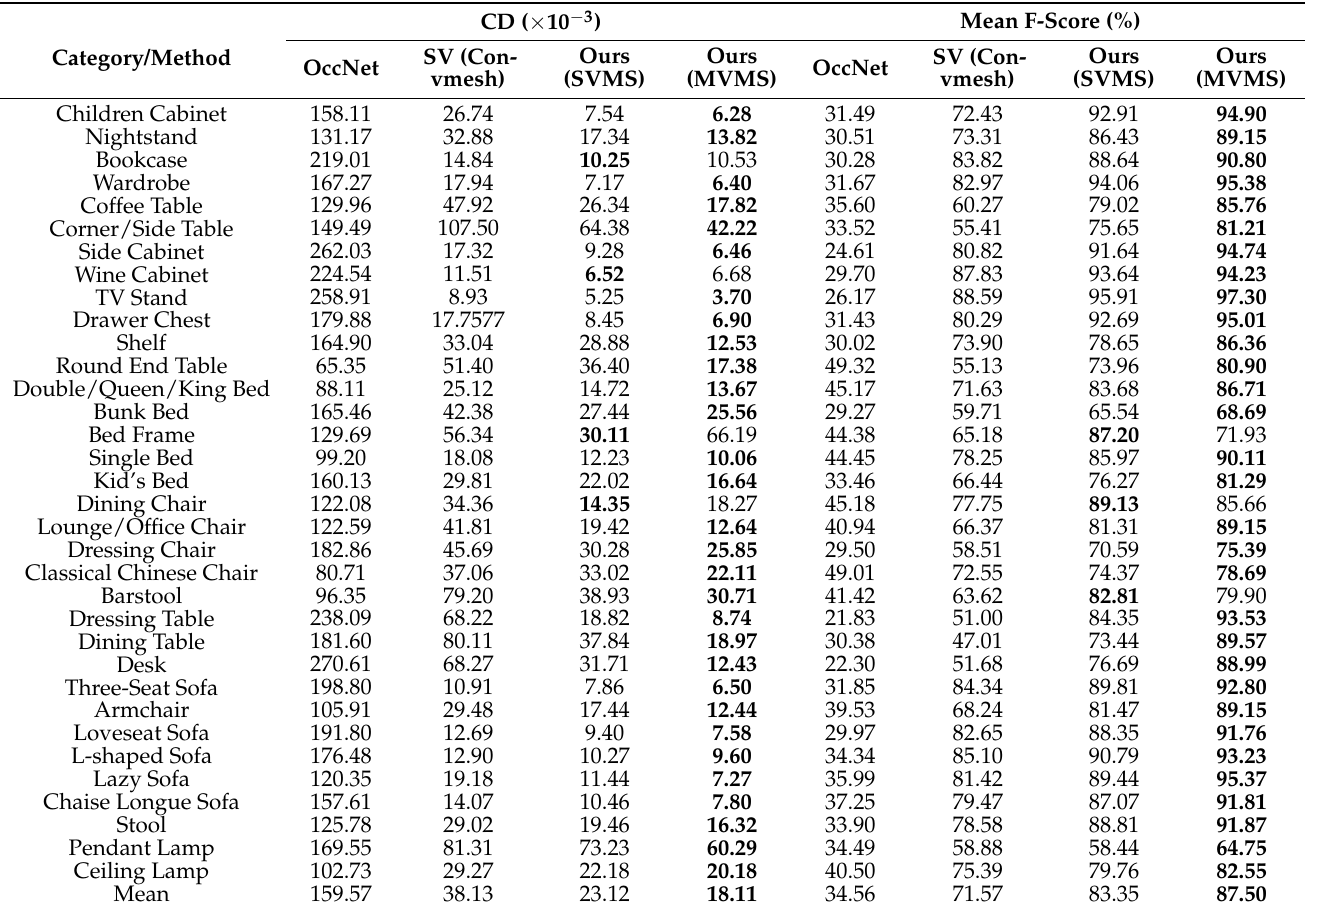
Table 1. The quantitative comparison